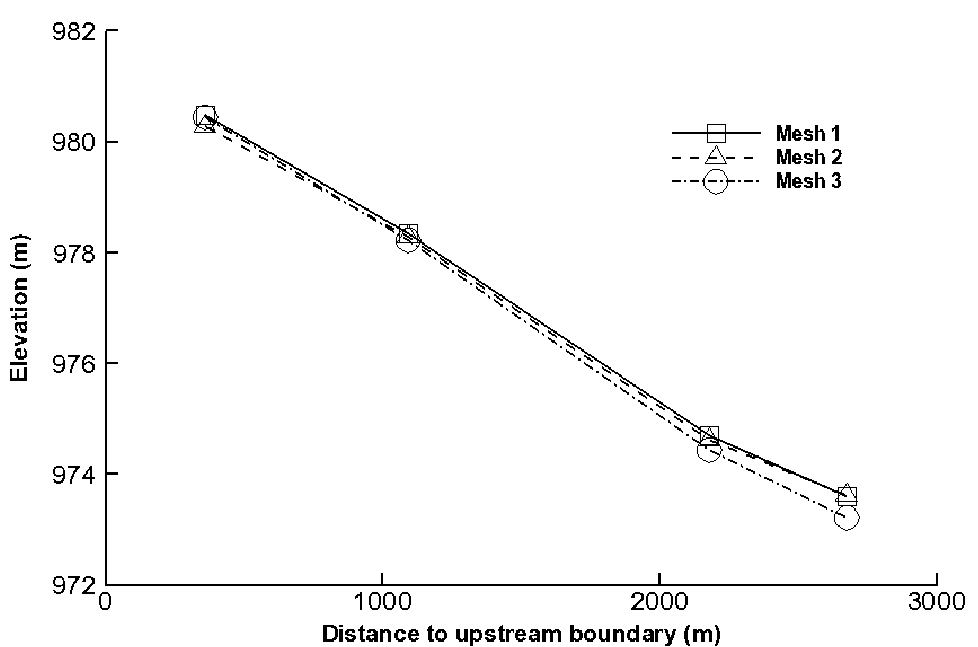
Figure 4. Comparison of the water levels for different meshes.